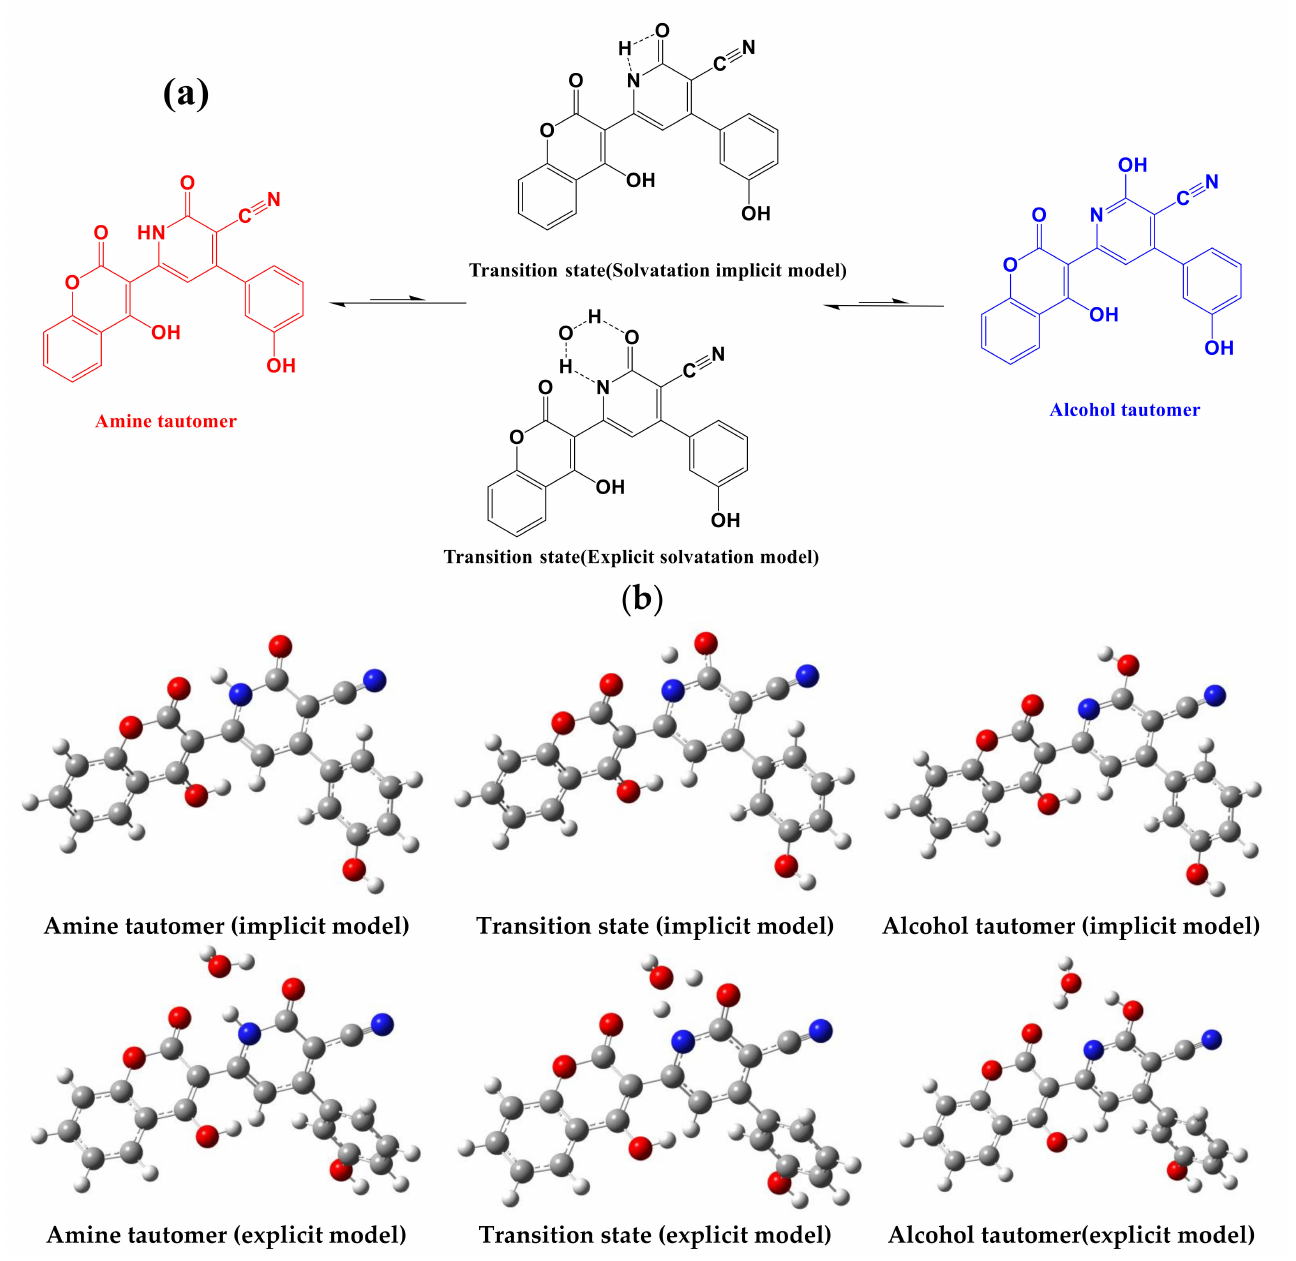
Figure 4. ( a ) Proposed tautomeric equilibrium for compound 3 ; ( b ) optimized TSs, amine and alcohol tautomers at DFT B 3 LYP/6-31+G(d) level of